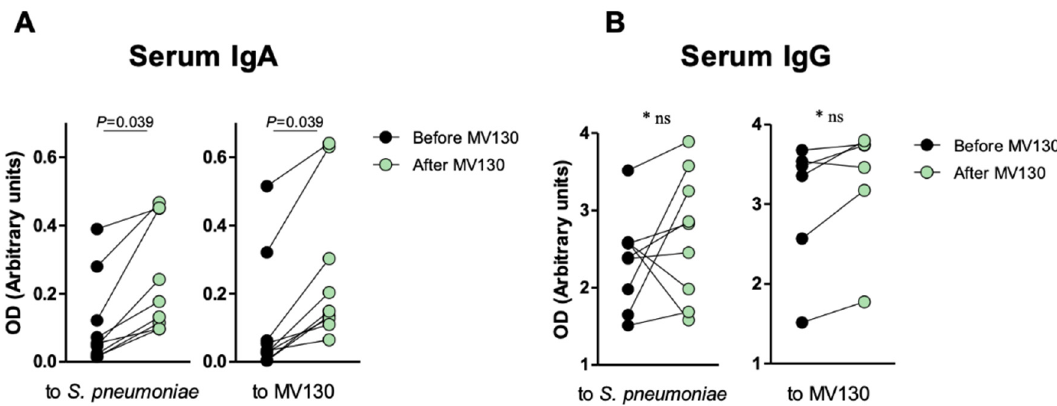
Figure 4. Specific anti-MV130 IgA and IgG antibodies. Prophylaxis with MV130 increases serum IgA antibody production. ( A , B ) Serum IgA ( A ) and IgG ( B ) antibodies against S. pneumoniae (left panels) or the bacterial mixture (right panels), collected from subjects before and after 12 months following MV130 immunotherapy analyzed by ELISA. Data from 6–10 individuals are shown. Lines show paired values. Normal distribution was evaluated using the Shapiro–Wilk test. p values were calculated using Paired Student’s t -test or Wilcoxon signed-rank test.